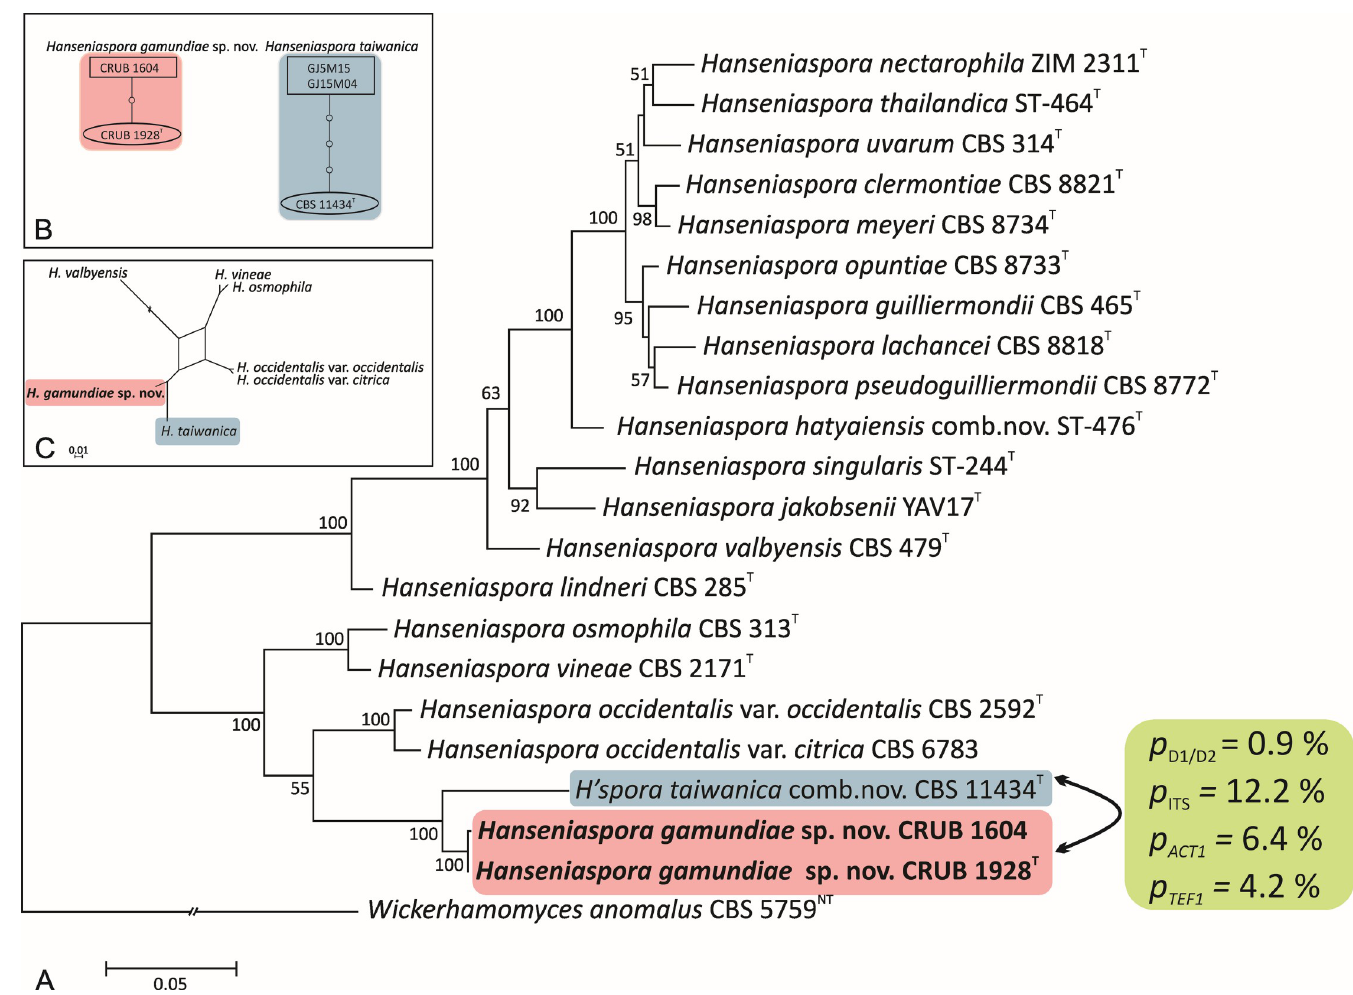
Fig 1. Placement of Hanseniaspora gamundiae sp. nov. within the genus Hanseniaspora based on the sequences of the ITS and the D1/D2 LSU regions of the gene encoding the rRNA, as well as the genes encoding actin and elongation factor-1 α (EF-1 α ) proteins. (A) A phylogenetic tree inferred using Maximum-Likelihood analysis based on the Nei-Tamura model in MEGA6 [39]. Bootstrap analysis was carried out with 1000 pseudoreplicates [40]; only values above 50% are shown. Wickerhamomyces anomalus was used as the outgroup. Bar, nucleotide substitutions per site. p , indicating percentage of substitutions between the two marked sequences for each of the four individual genes or p- distance. (B) Parsimony networks based on the ITS and D1/D2 LSU of the rRNA gene sequences of strains of H . gamundiae sp. nov. and its closest relative H . taiwanica . Each connecting line represents a single nucleotide substitution, and each small circle indicates a missing intermediate haplotype. The rectangle indicates the sequences identified as ancestral by the analysis. Analyses were performed using TCS 1.21 [42]. (C) A consensus network showing relationships between H . gamunidae and its closest relatives. H . mollemarum [6] is not included in phylogenetic analyses.